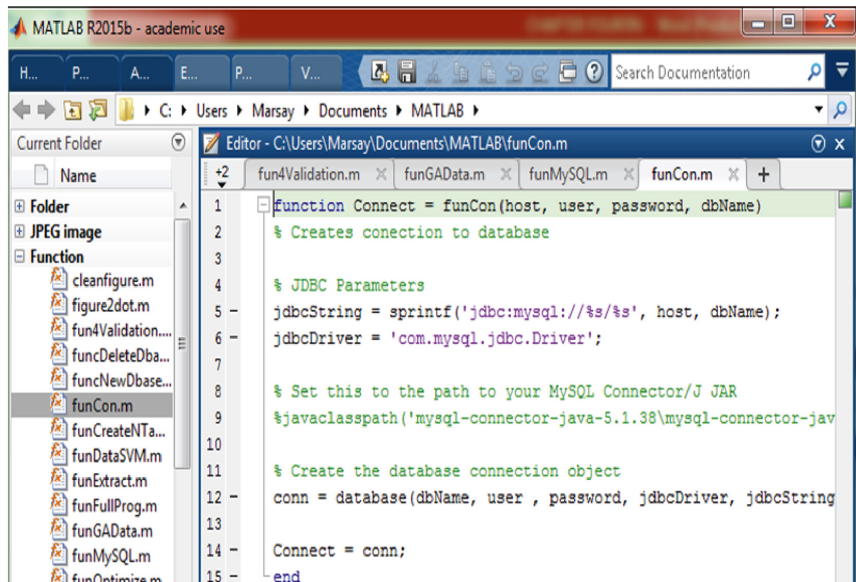
Figure 6: MATLAB-based decision support engine connection to the database.